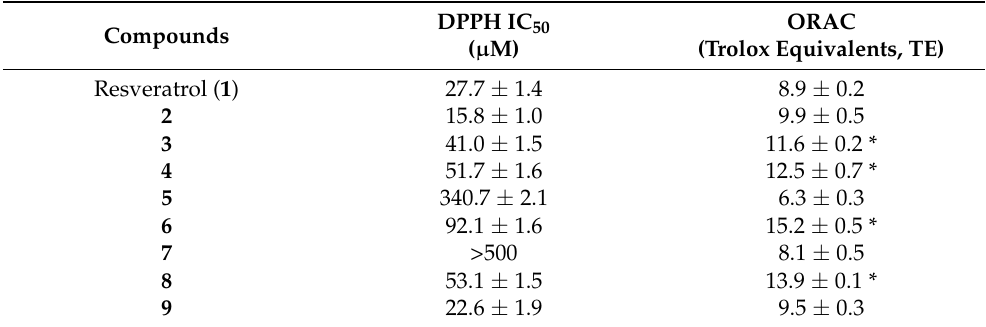
Table 3. ORAC values and DPPH radical scavenging activity of compounds 1 – 9 . Results are expressed as mean ± SEM. *: p < 0.05 by one-way ANOVA using Dunnett’s multiple comparison test to the parent compound, resveratrol. n = 2 for DPPH and 3 = ORAC assay.